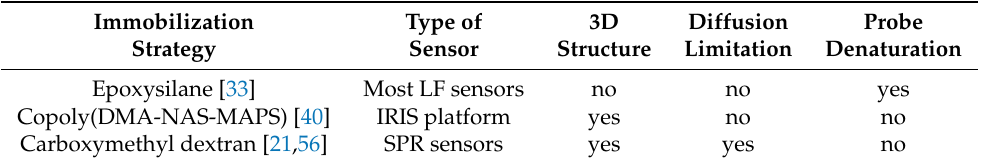
Table 1. Main features and limits of the immobilization methods for label-free bioassays dis- cussed